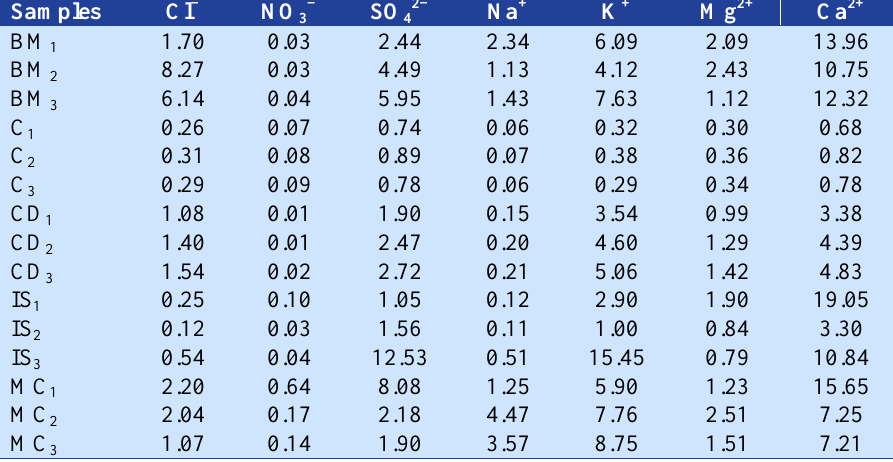
Table 1. Composition of ions in indoor ash residues (%) Samples